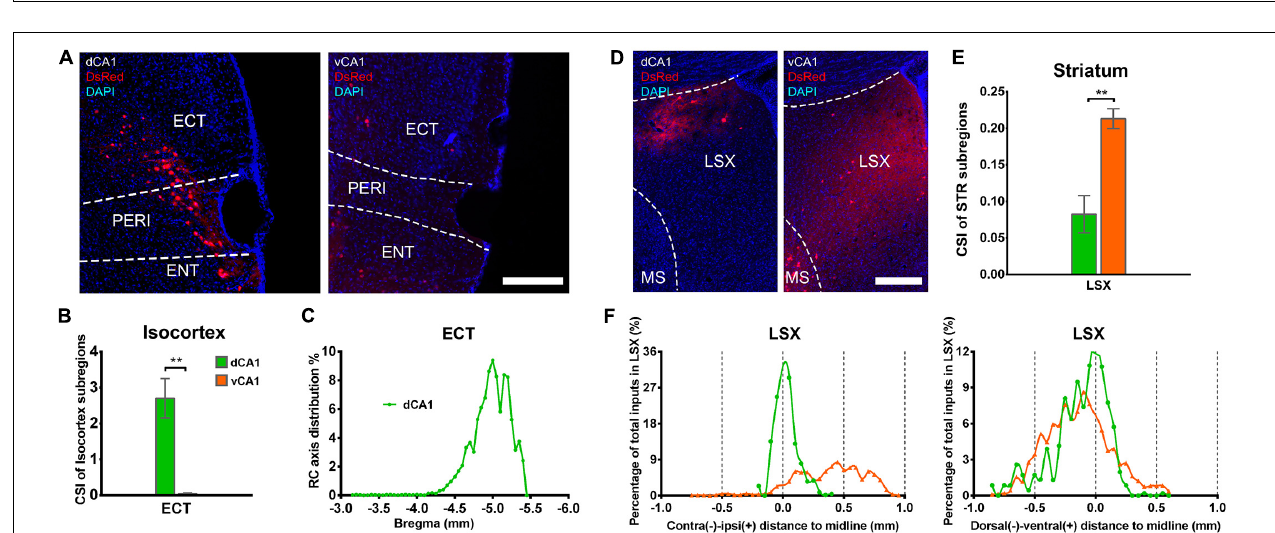
FIGURE 6 | Distribution patterns of bilateral inputs in PAL subregions between the two CA1 tracing groups. (A) Representative images showing MS and NDB inputs to the dorsal or ventral CA1 PNs. Scale bar: 500 µ m. (B) CSI of the inputs in bilateral PAL subregions. (C) Distribution patterns of the input neurons along the RC axis in the bilateral MS or NDB. (D) The contralateral-ipsilateral distribution patterns of monosynaptic inputs in MS or NDB of two tracing groups. (E) The dorsal-ventral distribution patterns of monosynaptic inputs in MS or NDB of two tracing groups. n.s., no significant difference; ** P < 0.01.